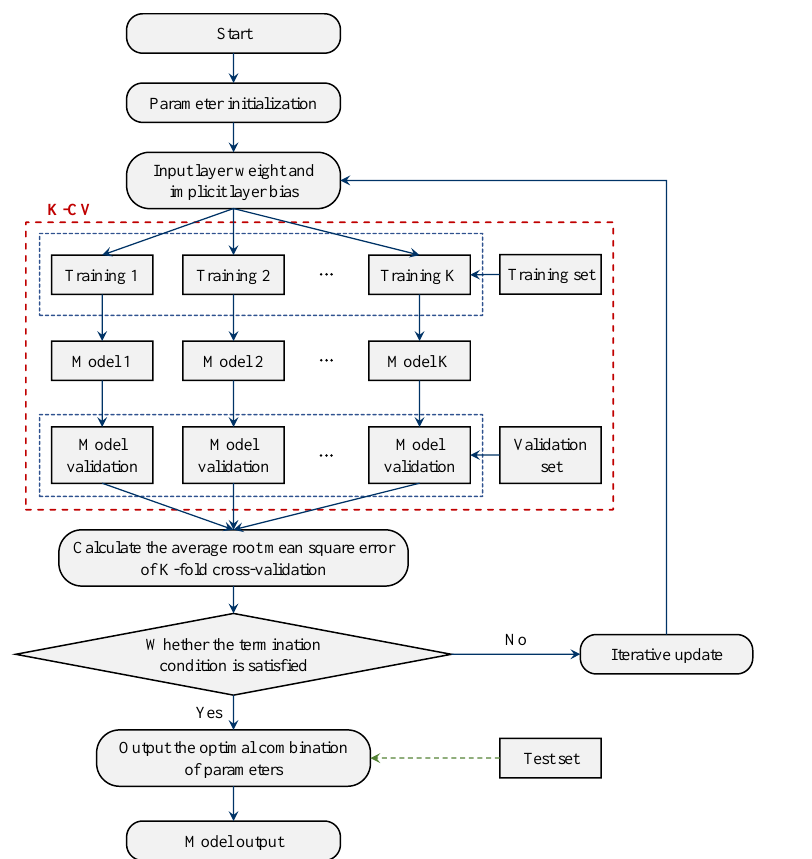
Figure 5. Schematic diagram of the implementation process of the fusion of K-CV and machine learning algorithm.